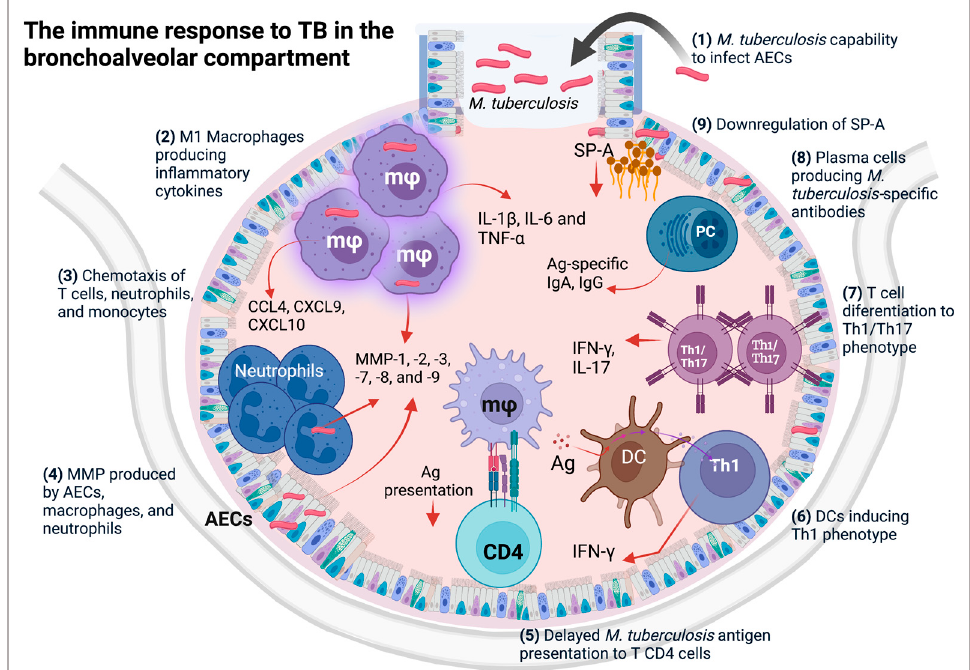
Figure 3. After entering the bronchoalveolar space, M. tuberculosis bacilli (1) have the ability to infect AECs; (2) induce an inflammatory phenotype in macrophages; (3) stimulate the production of chem- okines for the recruitment of neutrophils, monocytes, and T and B lymphocytes; (4) induce the pro- duction of metalloproteinases; (5) induce a delay in M. tuberculosis antigen presentation by macro- phages to T lymphocytes; (6) induce the differentiation of Th1 lymphocytes through DCs; (7) favor the differentiation of Th1/Th17 lymphocytes; (8) induce M. tuberculosis IgA and IgG antibodies; and (9) decrease the production of surfactant (created with